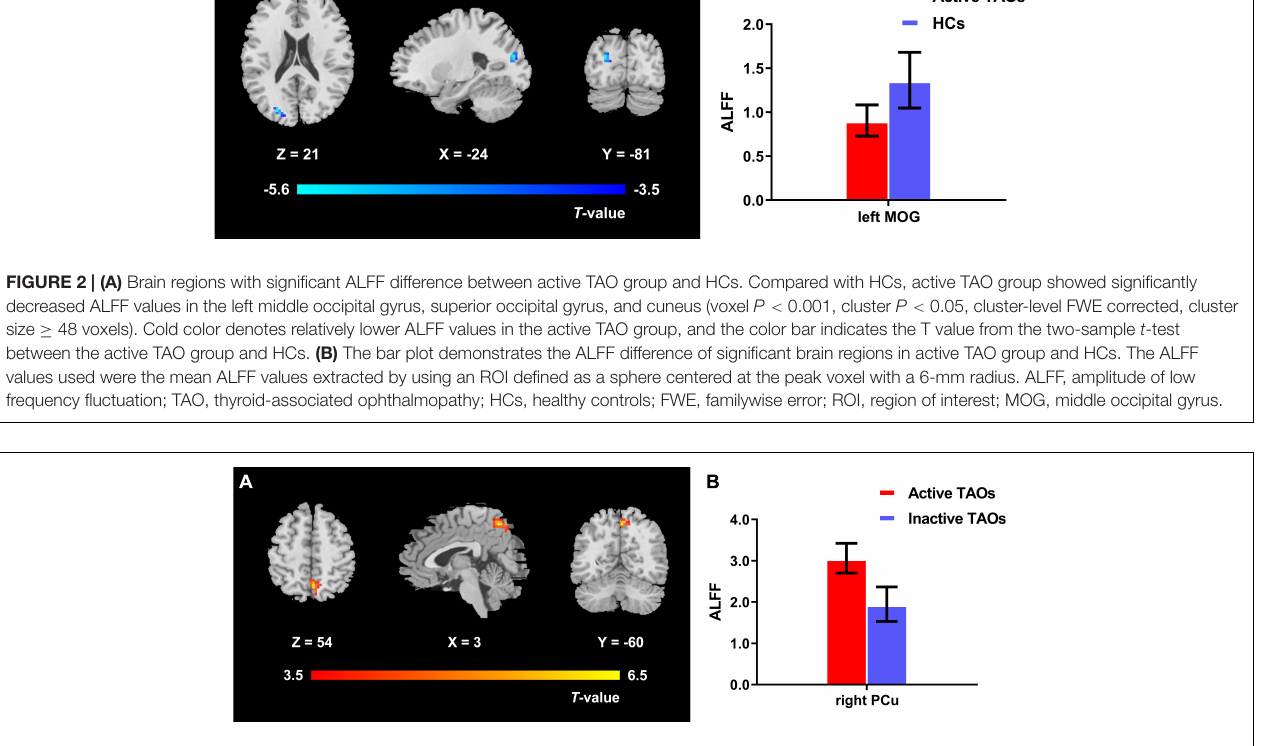
FIGURE 3 | (A) Brain regions with significant ALFF difference between active and inactive TAO groups. Compared with the inactive TAO group, the active TAO group showed significantly increased ALFF values in the bilateral precuneus (voxel P < 0.001, cluster P < 0.05, cluster-level FWE corrected, cluster size ≥ 64 voxels). Warm color denotes relatively higher ALFF values in active TAO group, and the color bar indicates the T value from the two-sample t -test between the active and inactive TAO group. (B) The bar plot demonstrates the ALFF difference of significant brain regions in the active and inactive TAO groups. The ALFF values used were the mean ALFF values extracted by using an ROI defined as a sphere centered at the peak voxel with a 6-mm radius. ALFF, amplitude of low frequency fluctuation; TAO, thyroid-associated ophthalmopathy; FWE, familywise error; ROI, region of interest; PCu,